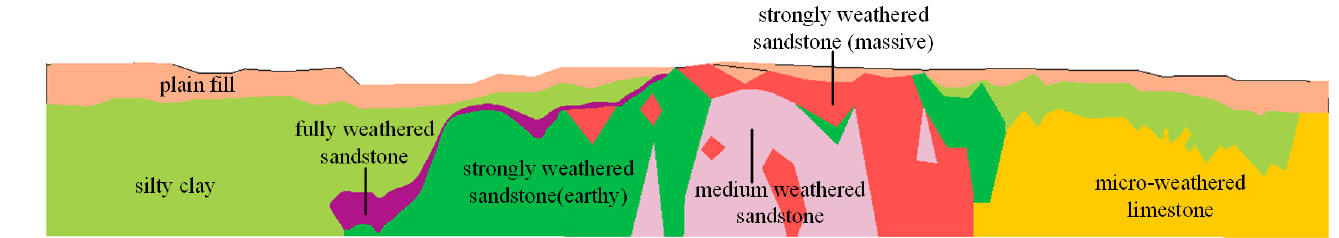
Figure 4. Geological longitudinal sections of stations and large and small mileage sections.